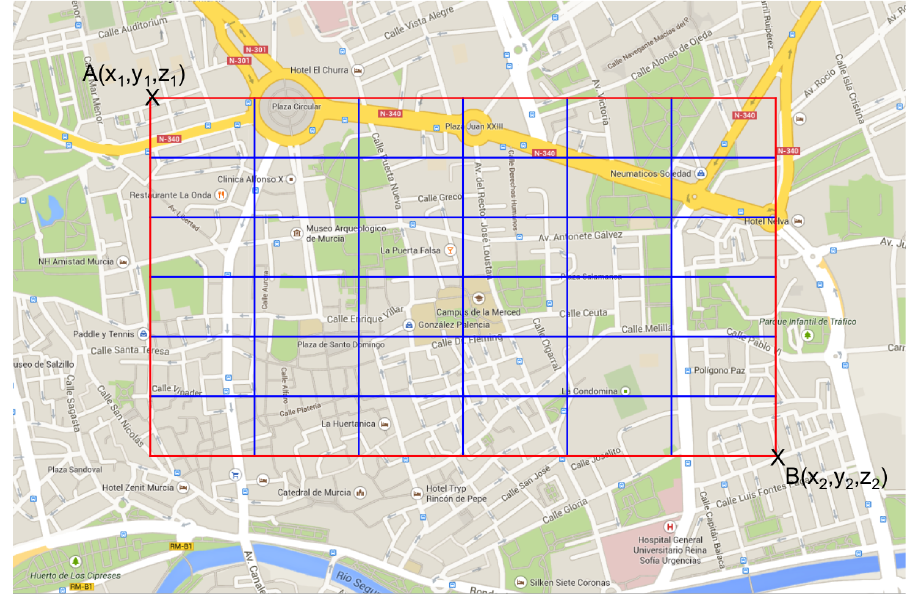
Figure 7. Definition of a RoI with 6 × 6